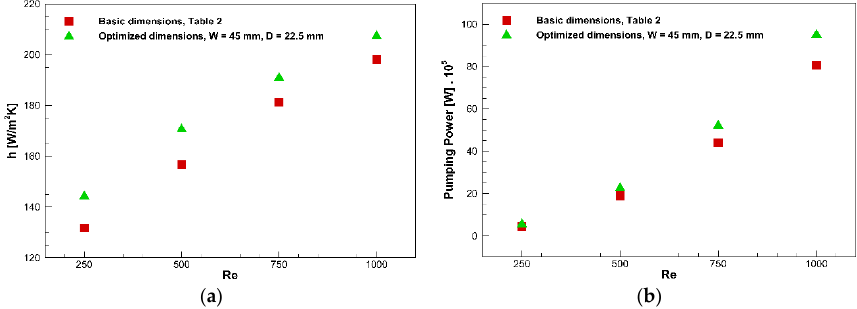
Figure 14. Comparison of the convection HTC ( a ) and pumping power ( b ) obtained from the current optimization and basic dimensions (Table 2) for the water / Al 2 O 3 nanofluid at ϕ = 3%.